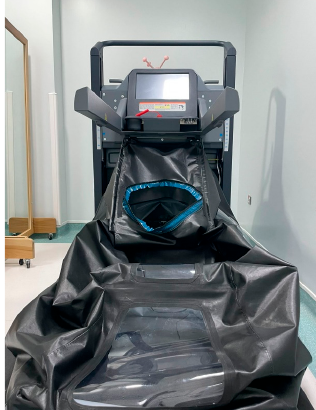
Figure 1. Lower Body Positive Pressure Treadmill (AlterG Anti-Gravity Treadmill).